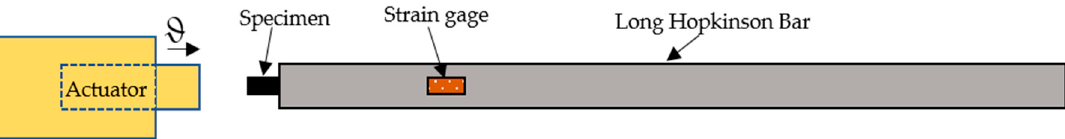
Figure 7. Schematic representation of intermediate strain rate compression test apparatus (Long Hopkinson bar setup).